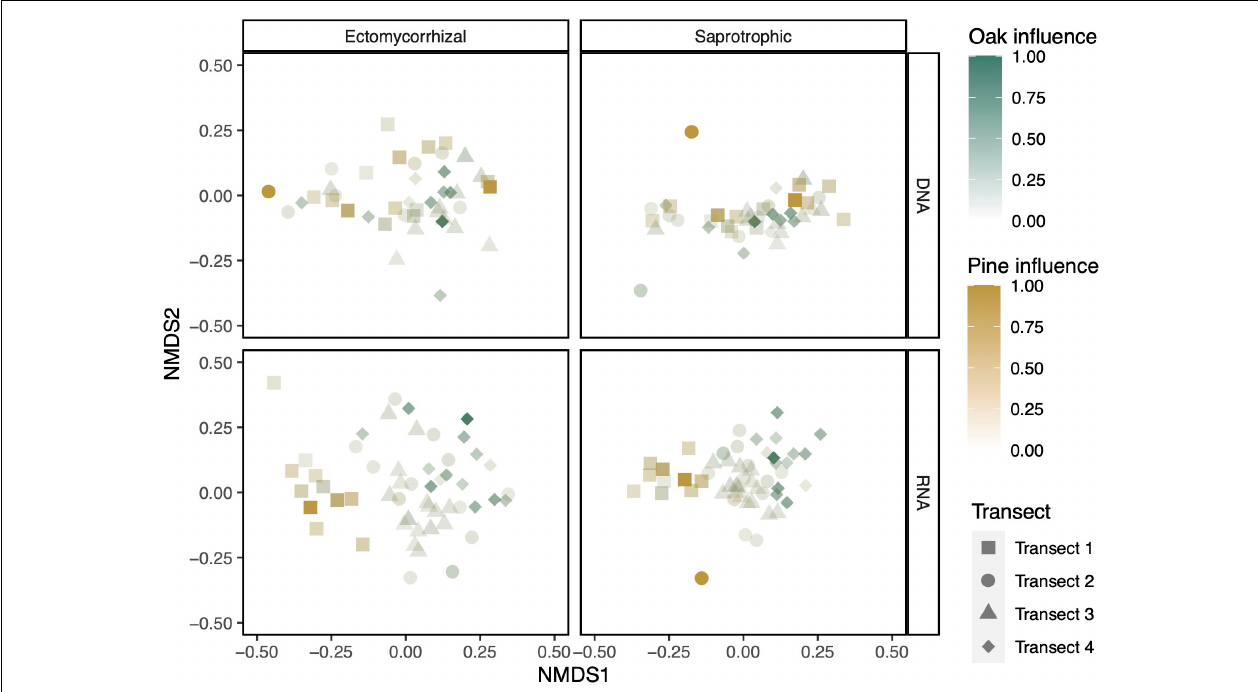
FIGURE 4 | NMDS plots show a separation by aboveground influence in both ectomycorrhizal and saprotrophic communities when displaying RNA but not DNA community data. Colors are scaled to the maximum influence of each canopy genus in any soil core. NMDS plots were constructed using Bray–Curtis dissimilarity. TABLE 1 | PERMANOVA results show the overlap in predictive parameters between saprotrophic and ectomycorrhizal fungi. DNA RNA Saprotroph Ectomycorrhizal Saprotroph